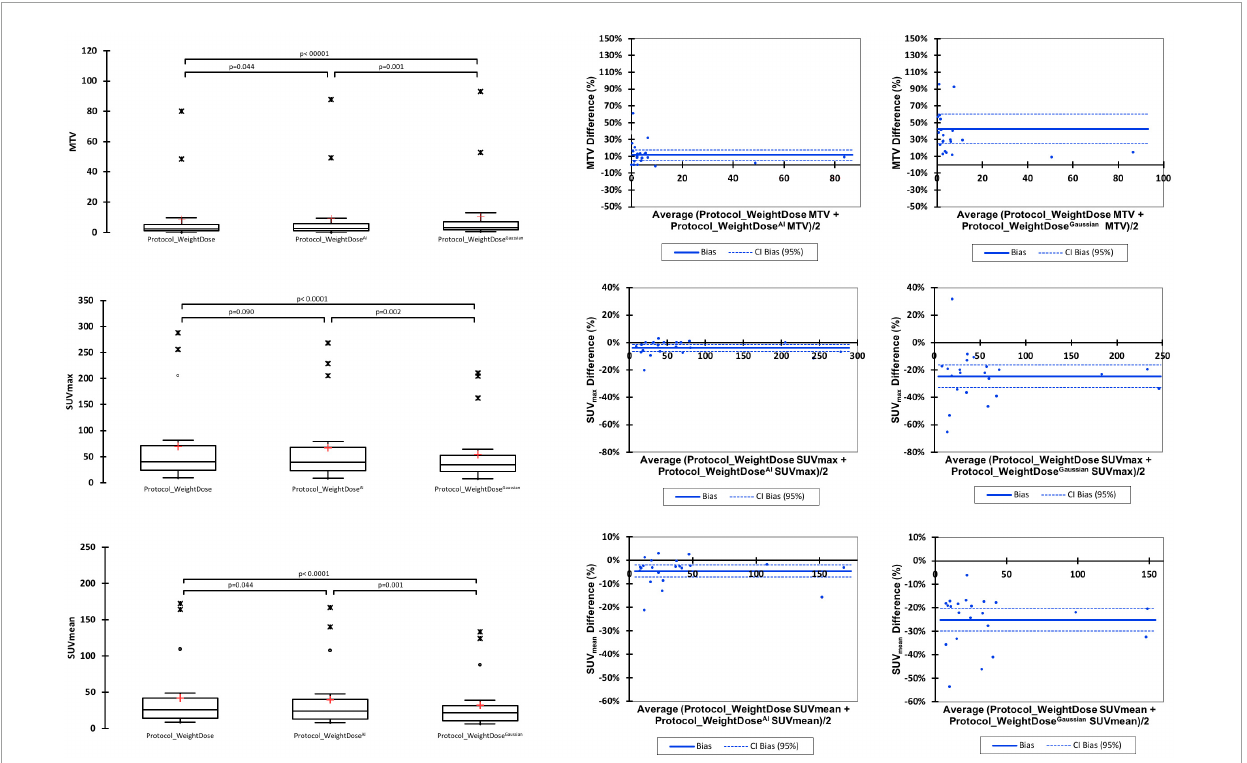
FIGURE2 Paired comparison of protocol_WeightDose, protocol_WeightDose AI , and protocol_WeightDose Gaussian quantitative values.